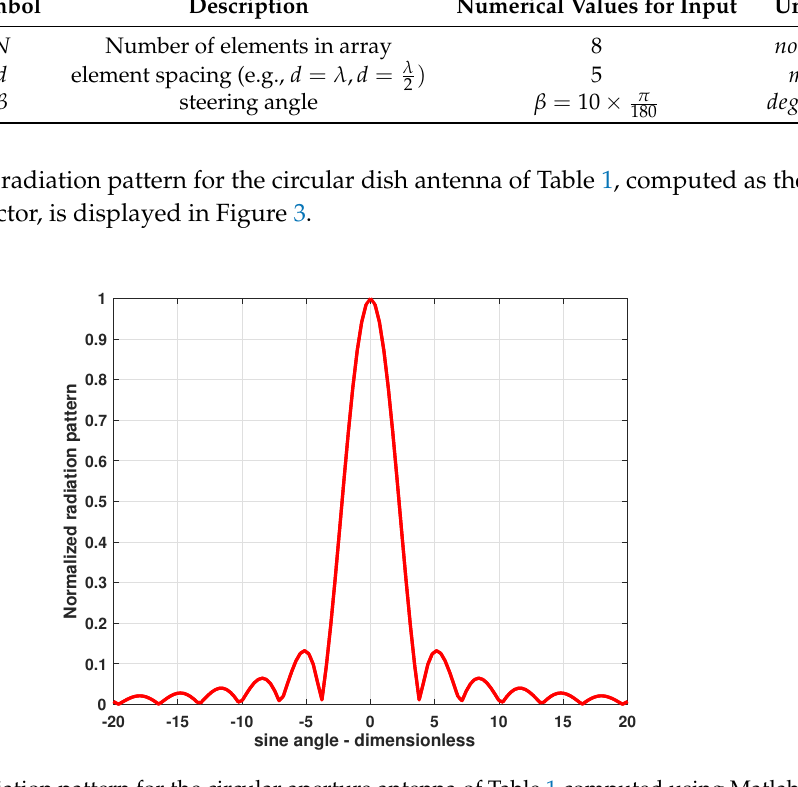
Figure 3. Radiation pattern for the circular aperture antenna of Table 1 computed using Matlab